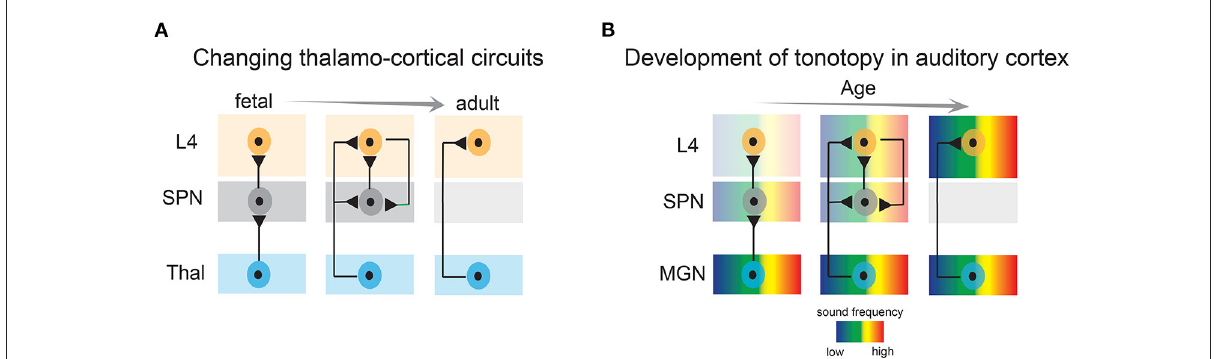
FIGURE3 Developmental emergence of thalamo-cortical connections and emergence of tonotopy in the auditory cortex. (A) Subplate neurons convey thalamic activity to layer 4 neurons during development, whereas in adults, thalamic axons directly activate layer 4 neurons. L4, layer 4; SPN, subplate neurons; Thal, thalamus. (B) Tonotopic organization in the auditory cortex first emerges by projections to the subplate, and subsequently in layer 4. MGN, medial geniculate